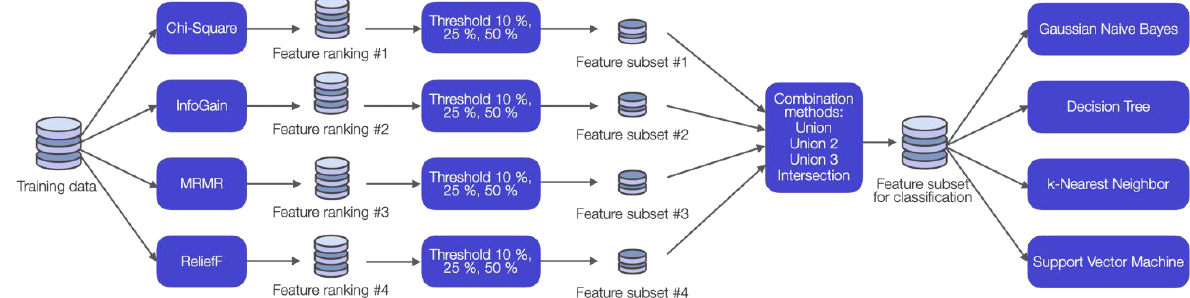
Figure 1. Workflow of the feature selection ensemble and the classification methods. Chi-square test (Chi-Square), Information gain (InfoGain), Minimum Redundancy Maximum Relevance (MRMR) and RelieF rank the features. Then, a threshold reduced this ranked list to a feature subset. A combination method combined these four feature subsets to a final feature subset for classification. Three different thresholds were investigated: 50%, 25%, 10%. Four different combination methods were investigated: Union, Union 2, Union 3,